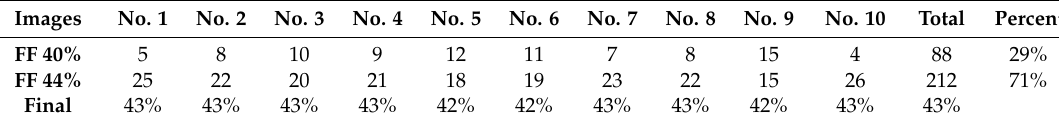
Table 1. Part of the results of fill factor estimation for the Teli dataset.